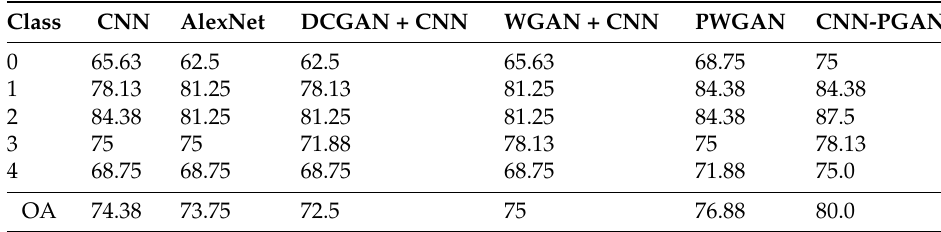
Table 6. The class-specific accuracy (%) and OA of different methods for DataSet2.